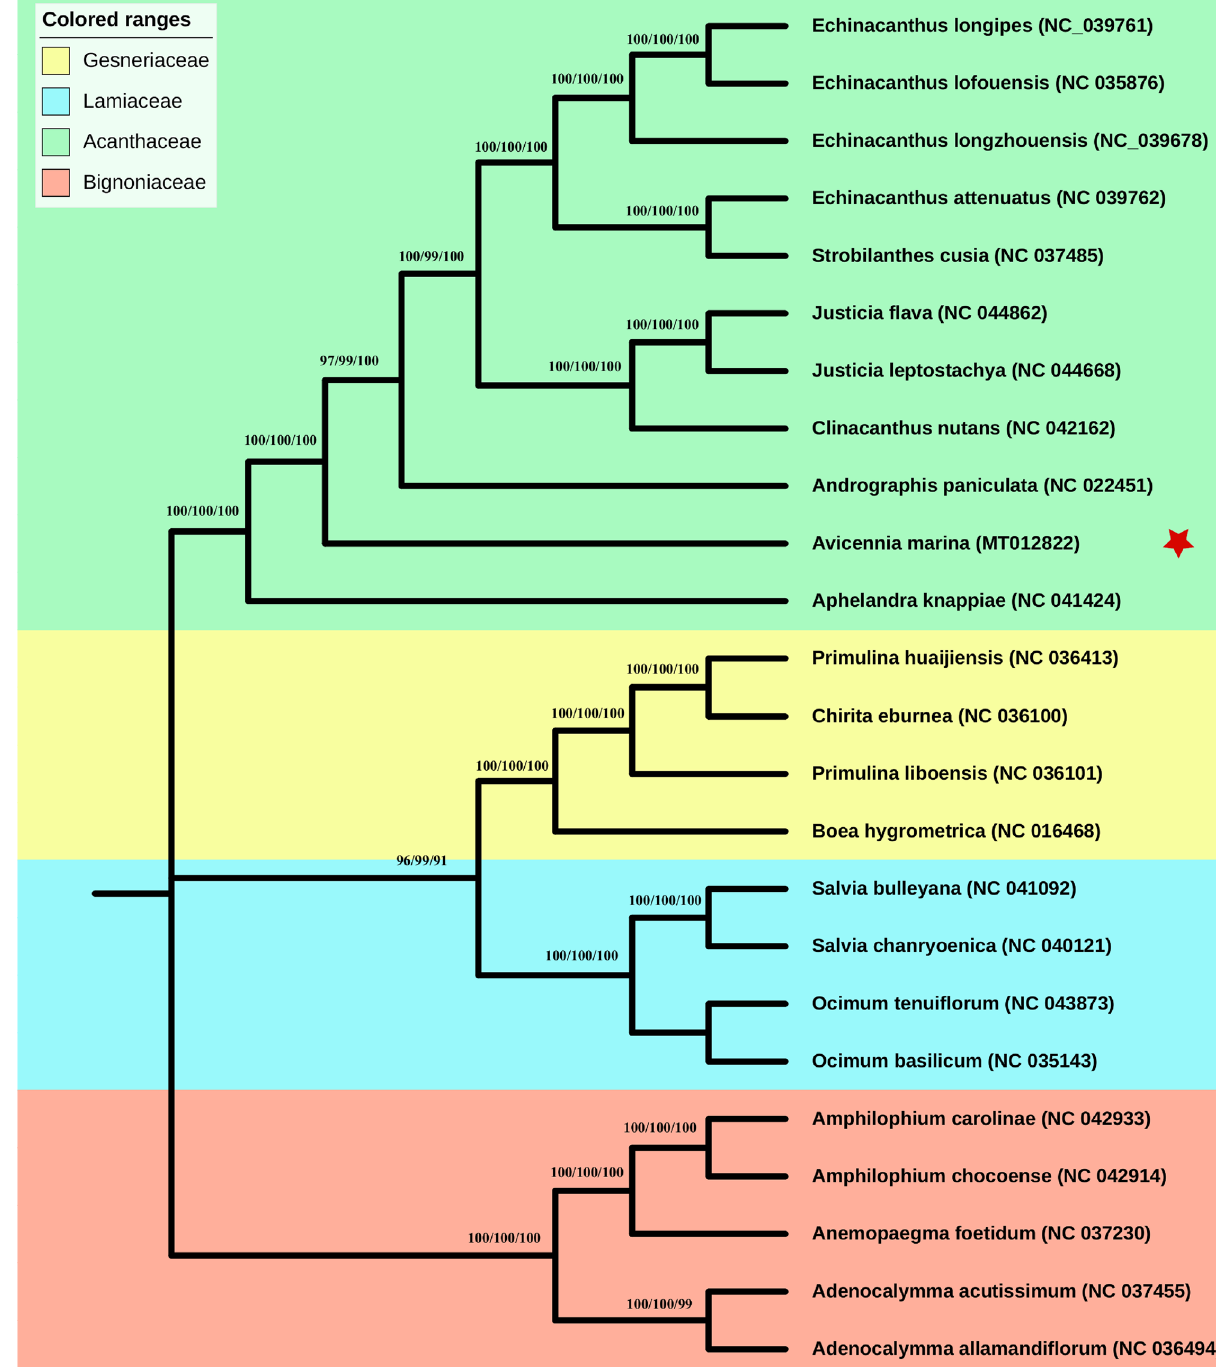
Figure 6. Phylogenetic trees were constructed for twenty-four species from four families using three different methods maximum likelihood (ML), maximum parsimony (MP) and neighbor -joining (NJ) by using 65 shared genes. Numbers above the branches are the bootstrap values of ML, MP and NJ respectively. Red star represents the position for Avicennia marina